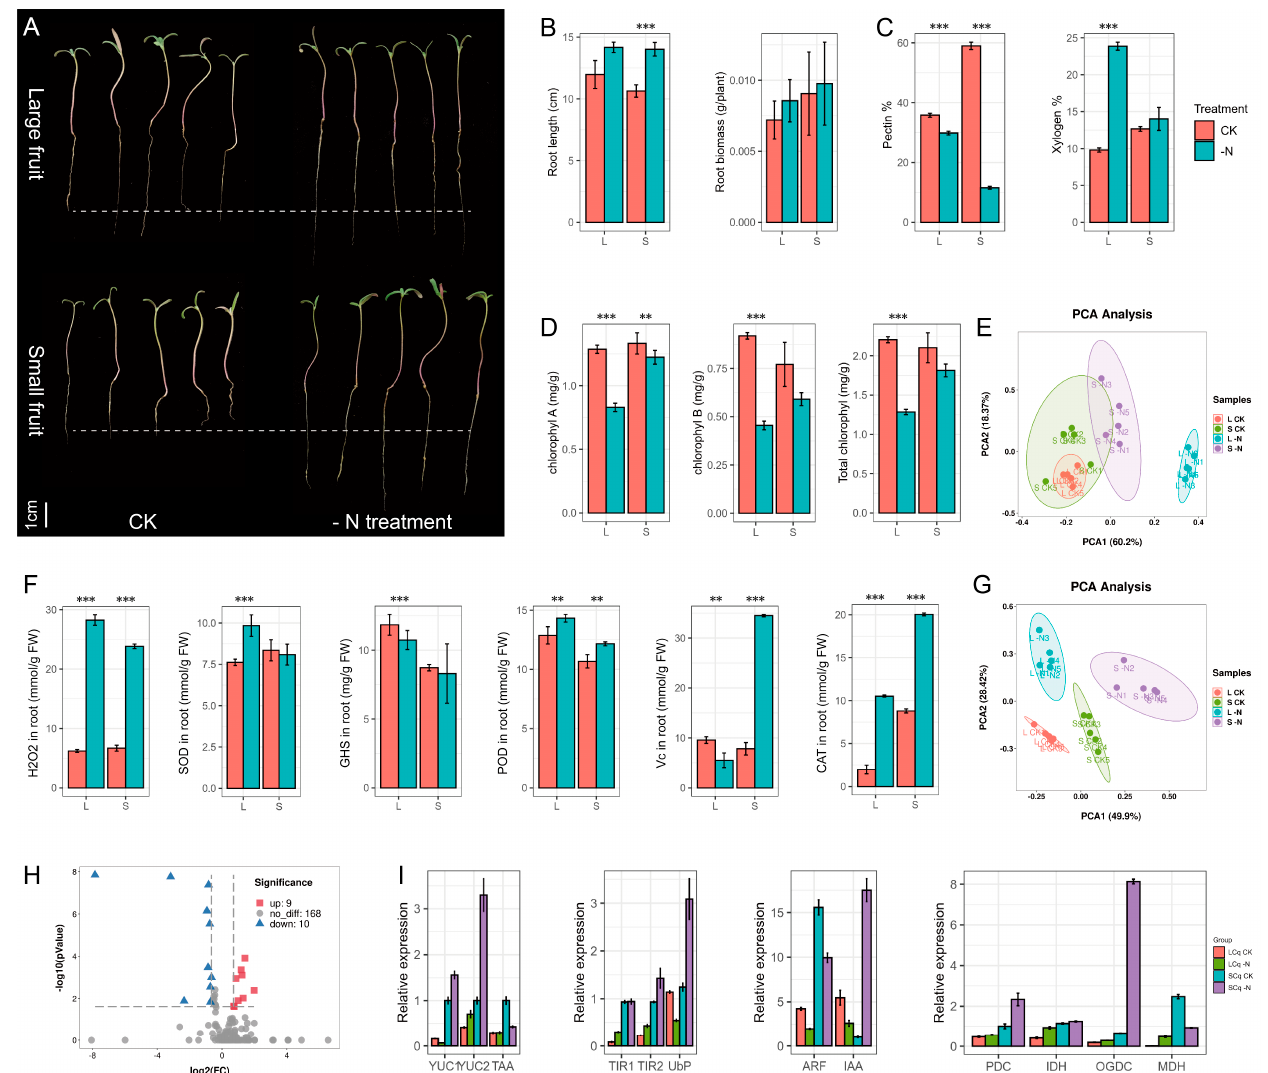
Figure 6. Physiological changes and gene expression differences of two quinoa seedlings in nitrogen-deficient environment. ( A ). Large-fruit and small-fruit quinoa seedlings under nitrogen deficiency stress. The first row was the big quinoa seedlings; the second row was the small quinoa seedlings; the left side and the right side were the control group and the experimental group, respectively; ( B – D ). Changes of physiological indexes of two quinoa seedlings under different treatments; ** statistical significance for p < 0.05; *** statistical significance for p < 0.001; ( E ). Principal component (PCA) analysis of physiological index data of two materials under two treatments. The points of red, green, blue, and purple represent the control group of LF quinoa, the control group of SF quinoa, the experimental group of LF quinoa, and the experimental group of SF quinoa. Five biological repeats in each group ( F ). Response to stress responses of two quinoa varieties under different treatments ( G ). Principal component (PCA) analysis of physiological index data of two materials under two treatments. ( H ). Auxin biosynthesis, auxin signal transduction, and differential expression genes of TCA cycle pathway in two quinoa seeds. The volcanic map is generated at a Foldchange > 2, p value < 0.05 threshold setting. Red and blue dots indicate genes that are significantly upregulated and downregulated in LF quinoa seeds, respectively; ( I ). Relative expression of genes CqIAAs , auxin pathway, and TCA pathway in different treatments of two quinoa. The genes used for qRT-PCR detection met the following conditions: the expression of quinoa seeds was significantly different and derived from the auxin pathway or TCA cycle